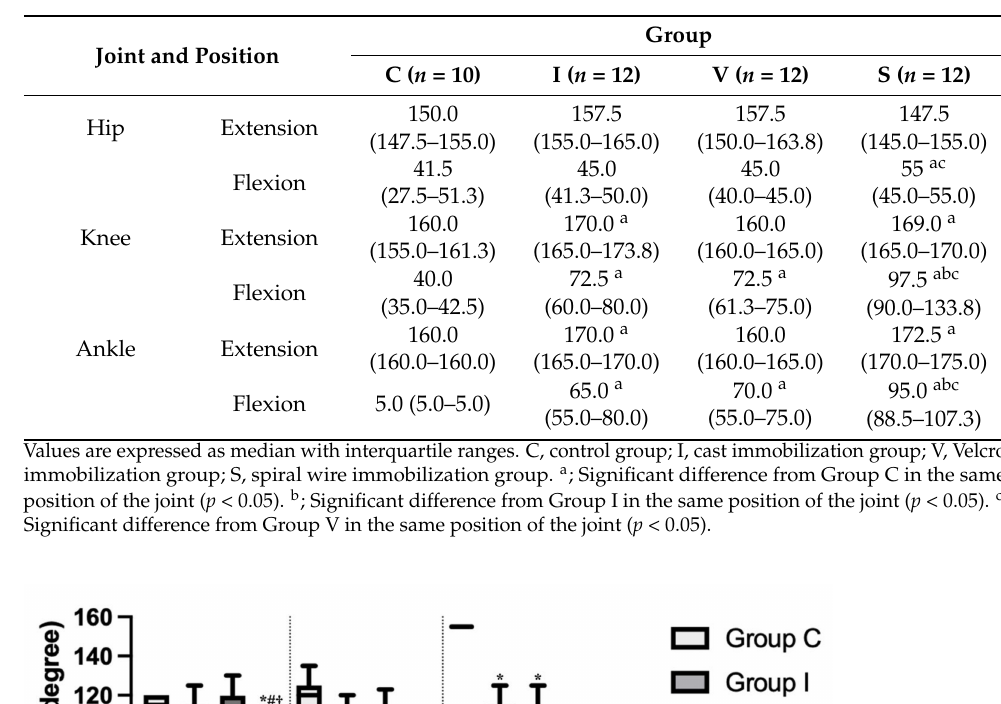
Table 4. Joint angle ( ◦ ) of rats in the control group and the three immobilization groups on Day 15.